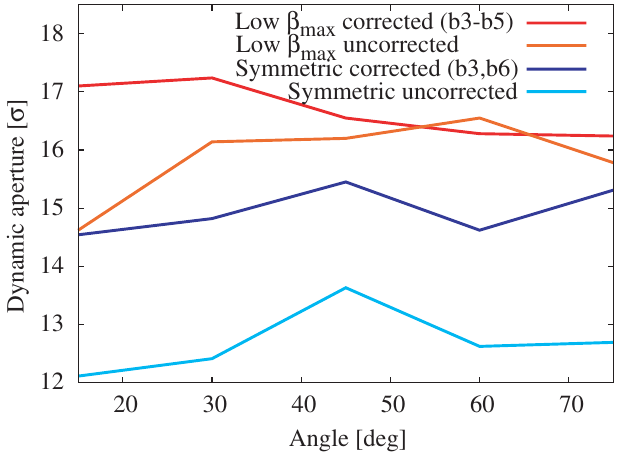
FIG. 3. (Color) Comparison of the minimum dynamic aperture for the LHC IR upgrade layouts low- (cid:3) max and symmetric with and without correction of the nonlinear magnetic errors in the low-beta